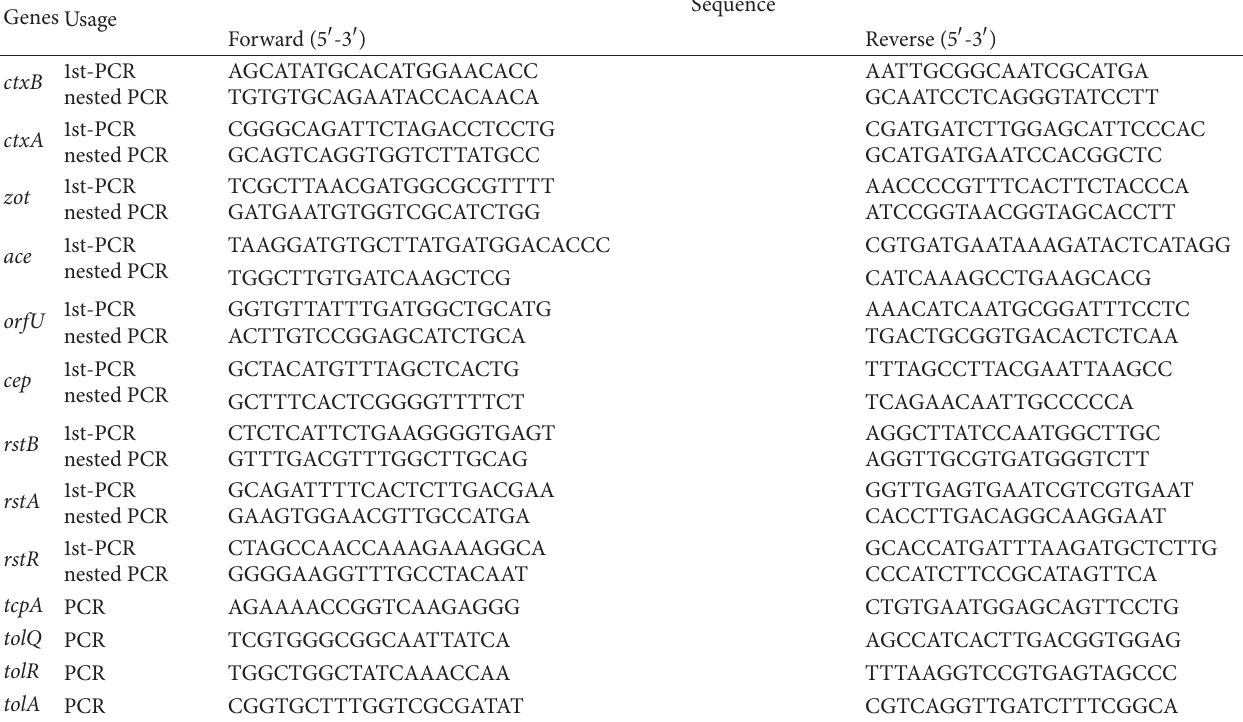
Table 1: Primer sequences used for the sets of PCR amplification. All primers were designed on the basis of the sequence of V. cholerae O1 El Tor N16961 (Genbank accession no.